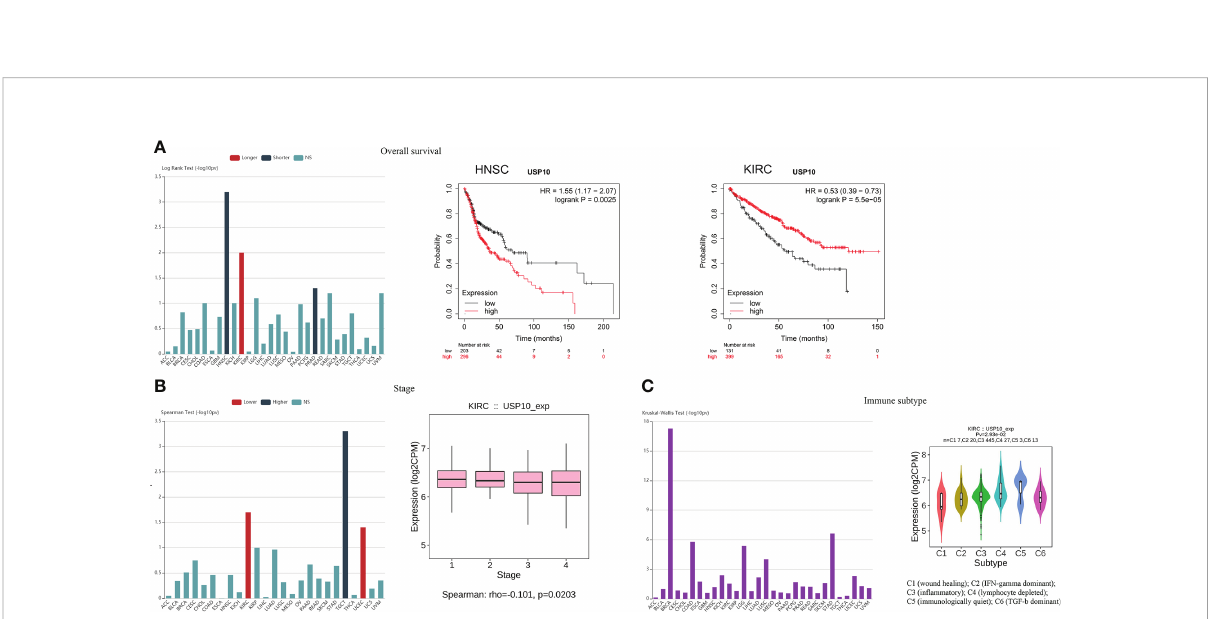
FIGURE 3 Analysis of the TISIDB and Kaplan-Meier plotter website indicated the role of USP10 in tumors and immune subtype. (A) HNSC patients with increased USP10 expression had lowered OS, however, high levels of USP10 were associated with prolonged OS in KIRC patients. (B) The correlation between USP10 expression and tumor stage in KIRC patients. (C) USP10 was correlated with the immune subtype in KIRC. NS, not signi fi cant. USP10, Ubiquitin-speci fi c peptidase 10; HNSC, head and neck squamous cell carcinoma; OS, overall survival; KIRC, kidney renal clear cell